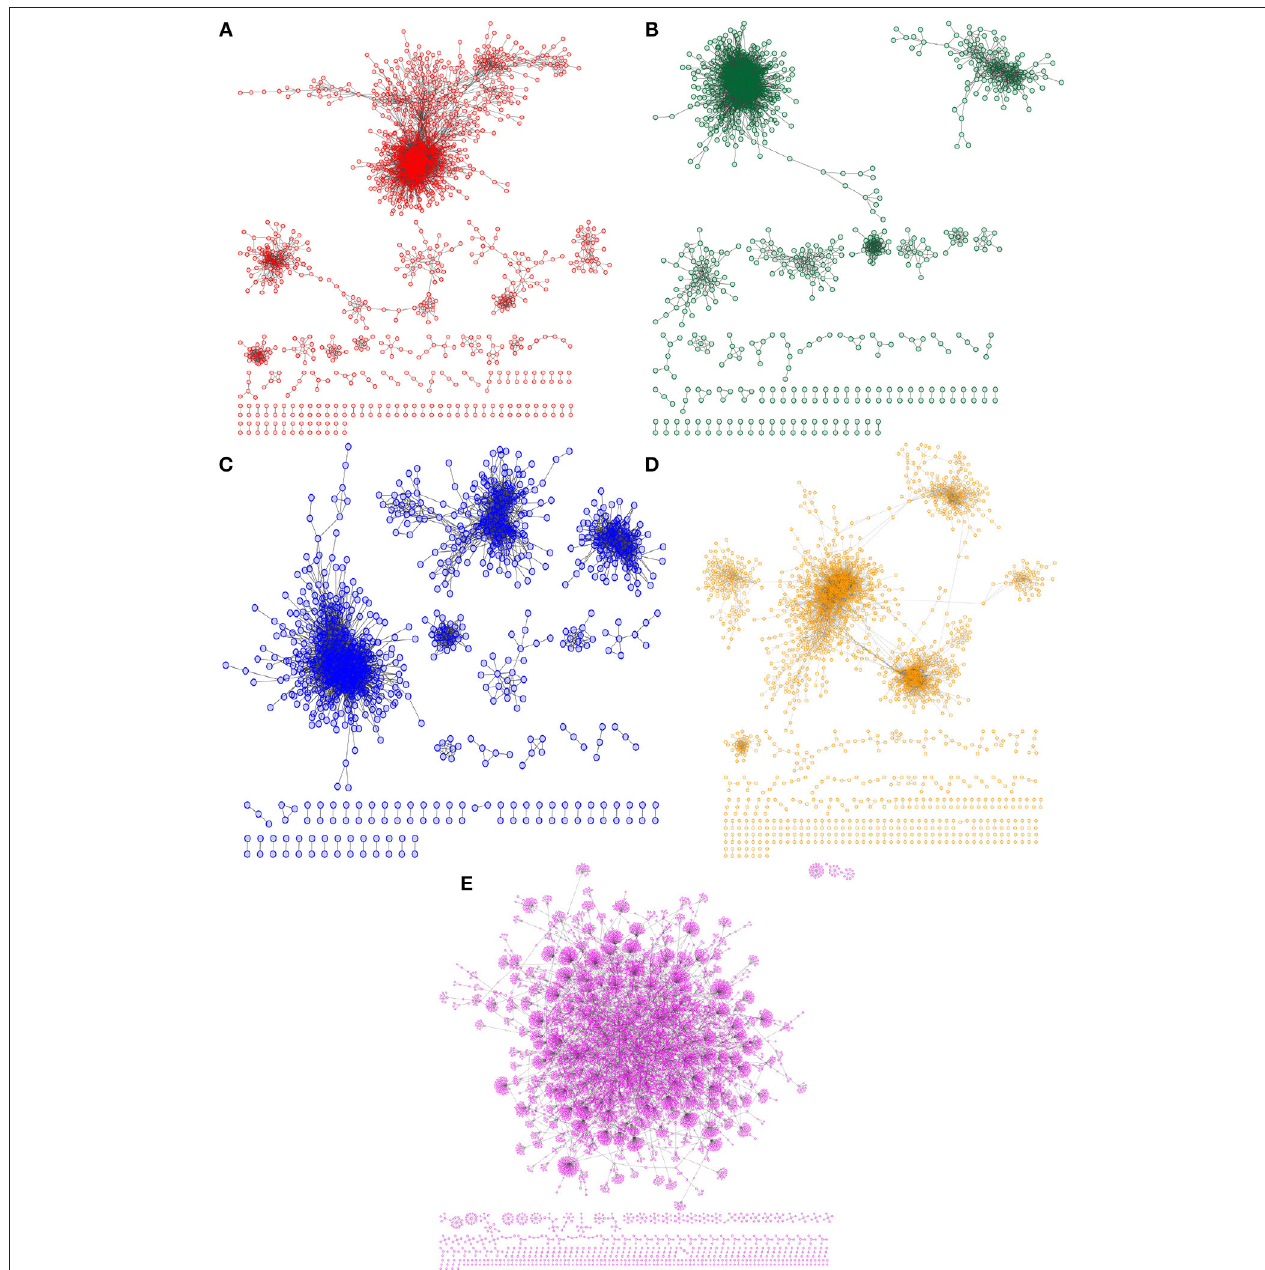
FIGURE 1 | Network architectures for breast cancer subtypes and non-tumor breast tissue. In each panel, the transcriptional network structure of each breast tumor subtype is shown: (A) Luminal A (red nodes); (B) Luminal B (green); (C) Basal (blue) (D) and HER2-enriched molecular subtype (orange). (E) Shows the transcriptional architecture for non-tumor breast tissue. Please notice the that (A–D) show networks with a large component and multiple medium-sized components, while (E) presents a network dominated by a single giant component, followed by small